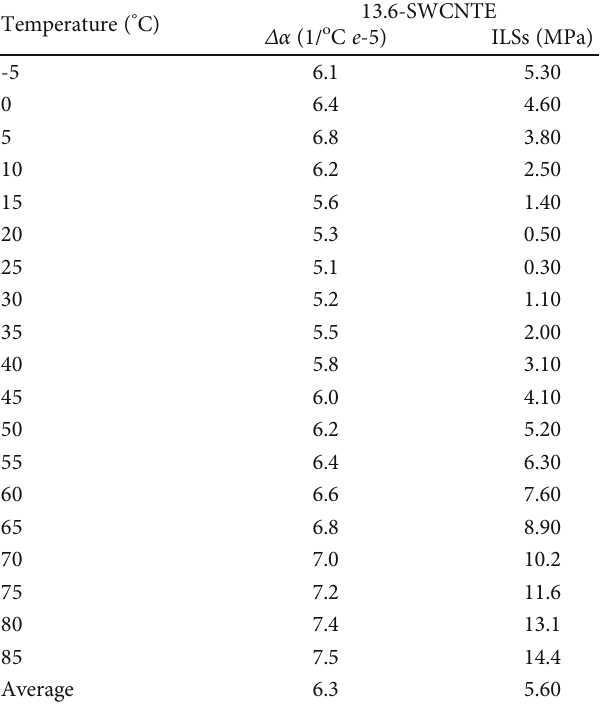
Table 6: Mismatches between the CTEs of 13.6-SWCNT and epoxy ( Δα ), and ILSs at the temperature range of -5 to 85 ° C within the